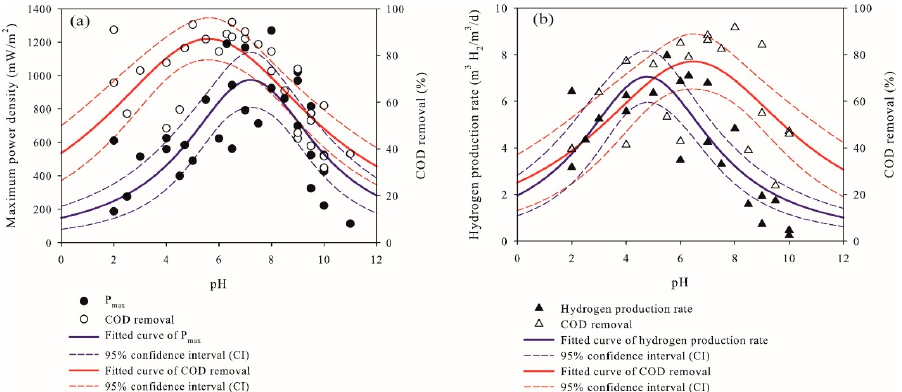
Figure 3. Influences of pH on ( a ) MFCs’ power generation and COD removal and ( b ) MECs’ hydrogen production and COD removal.